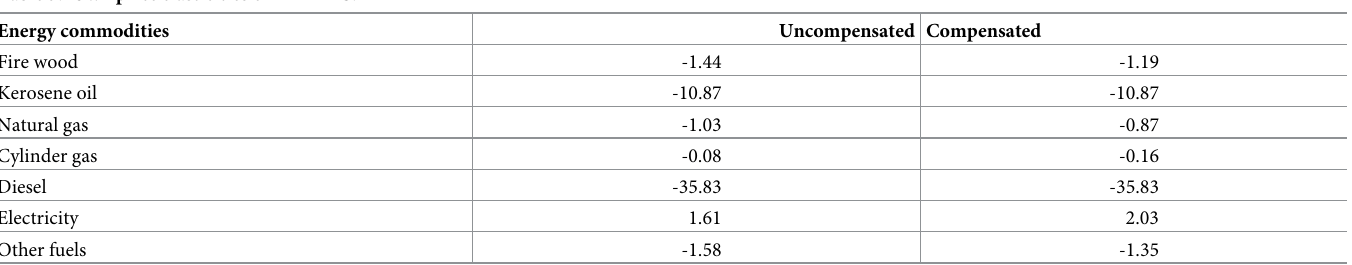
Table 5. Own price elasticities of LA-AIDS.